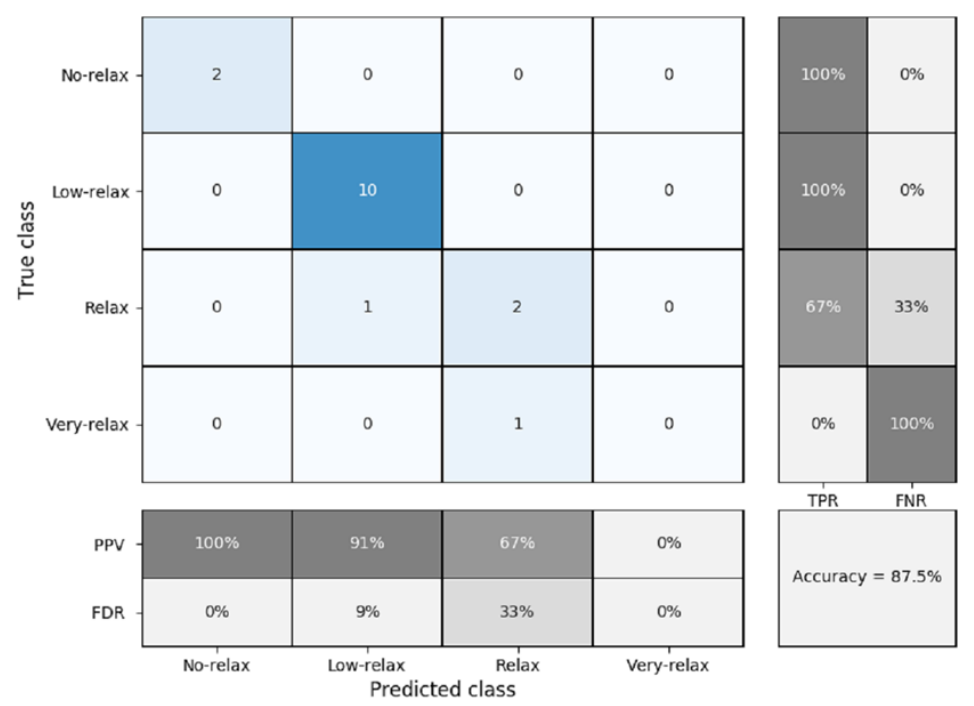
Figure 13. Confusion matrix for k-nearest neighbors (K-NN) classification and five-fold cross validation (boys), where PPV = positive predicted value, FDR = false discovery rate, TPR = true positive rate or sensitivity, and FNR = false negative rate or specificity.